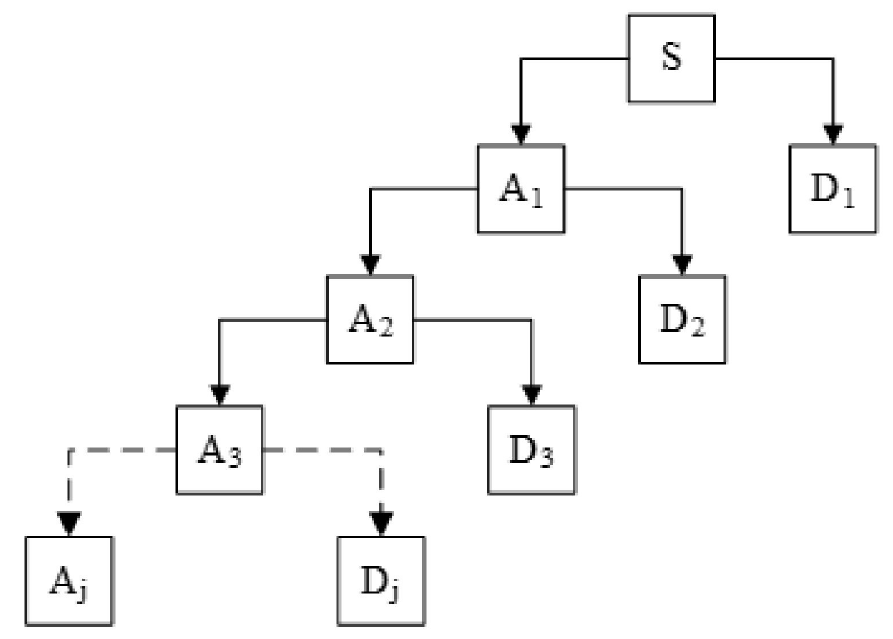
Figure 3. Wavelet coefficient decomposition